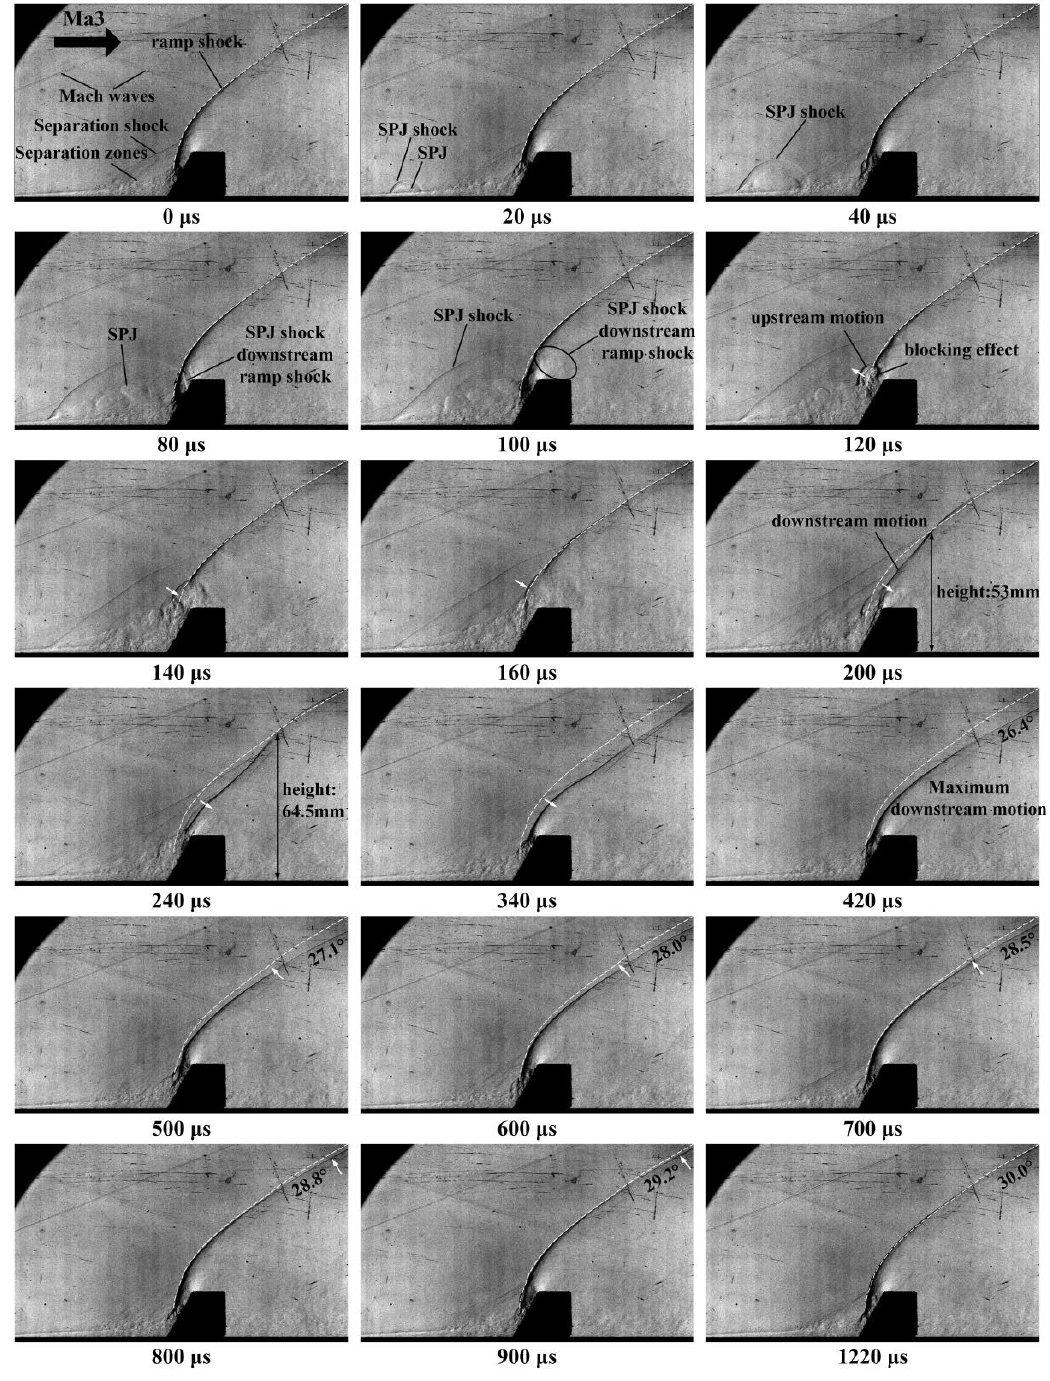
Figure 3. Interaction process between SPJ and the supersonic crossflow near the ramp in case1.